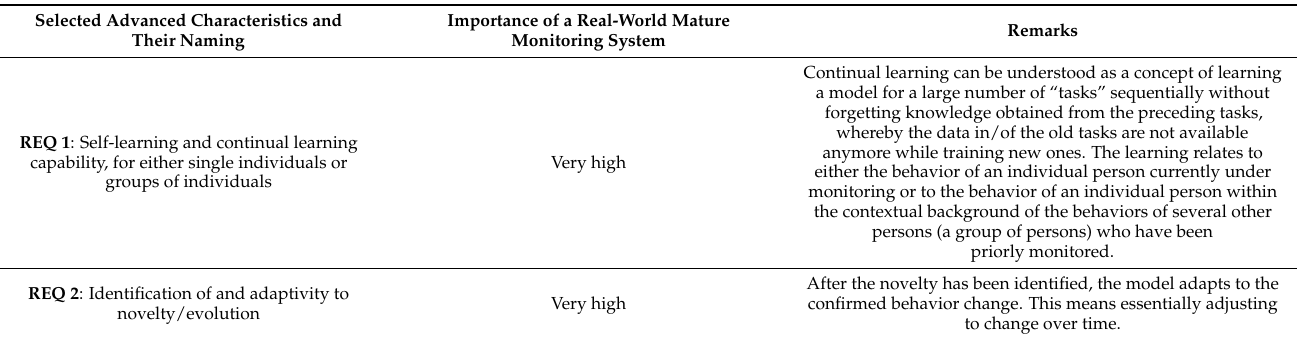
Table 4. Selected advanced characteristics of a robust and real-world mature abnormality detection system in the monitoring of humans in